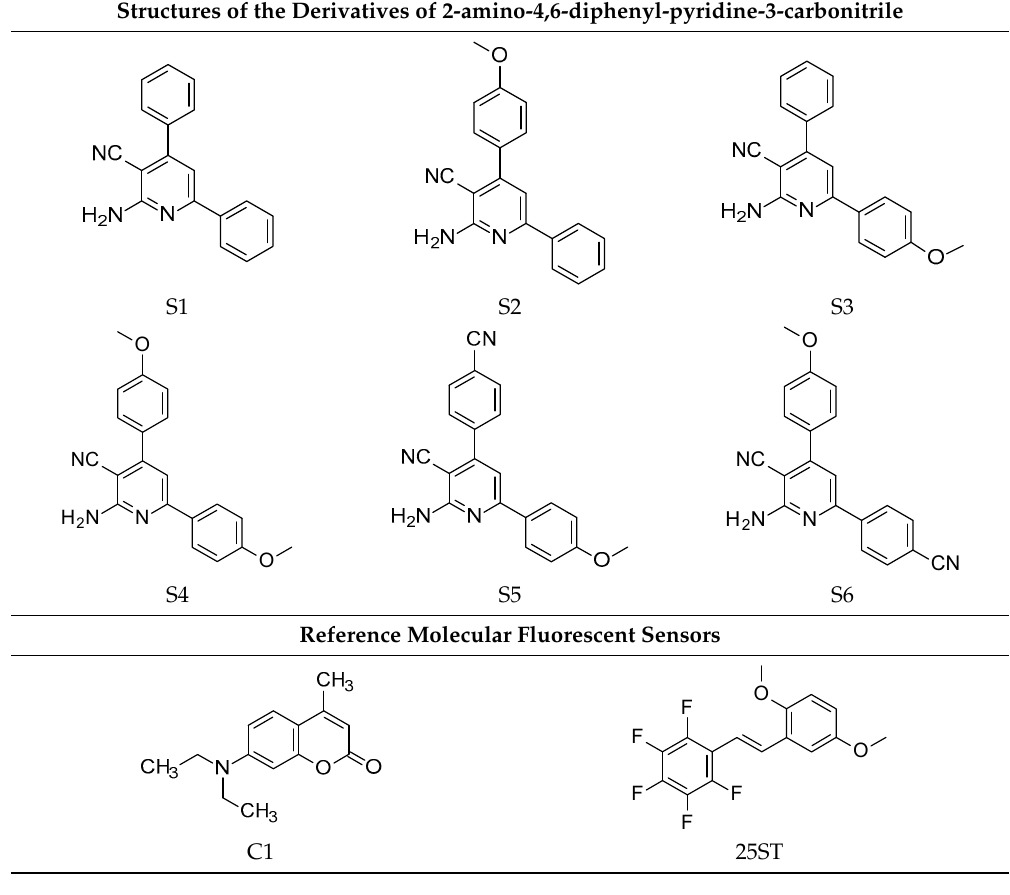
Table 1. Structures of investigated molecular fluorescent sensors for photopolymerization processes. Structures of the Derivatives of